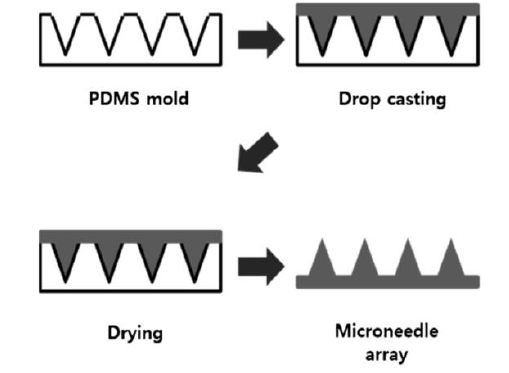
Figure 1. Fabrication process of PVA: PVP microneedle patch (6) .